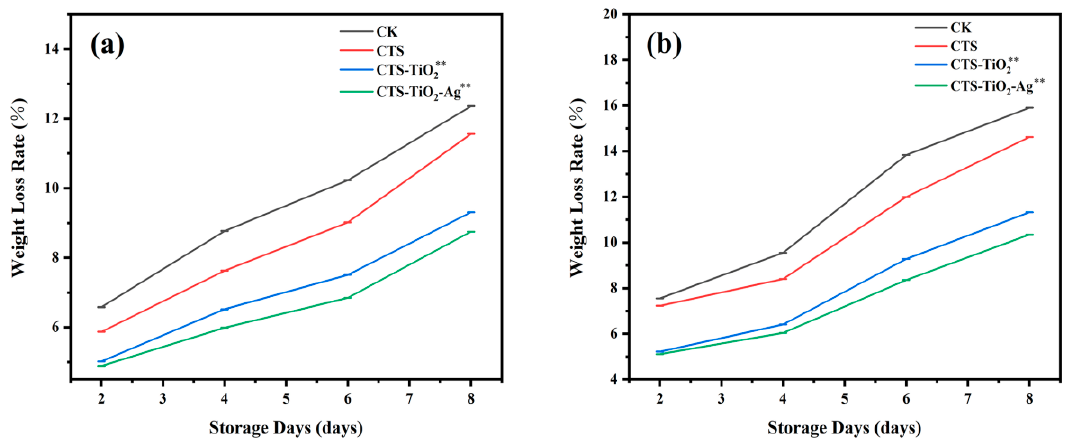
Figure 6. Effect of treatment with three different materials on weight loss rate: ( a ) potato; ( b ) strawberry. CK: Potatoes and strawberries without any treatment; CTS: CTS applied to form film-treated potatoes and strawberries; CTS-TiO 2 : CTS-TiO 2 applied to form film-treated potatoes and strawberries; CTS-TiO 2 -Ag: CTS-TiO 2 -Ag applied to form film-treated potatoes and strawberries. Data given demonstrate the average of at least three replications (n = 3) ± SD. Asterisks within rows indicate significant differences (* p < 0.05, ** p < 0.01, *** p < 0.001), according to Student’s t -test.